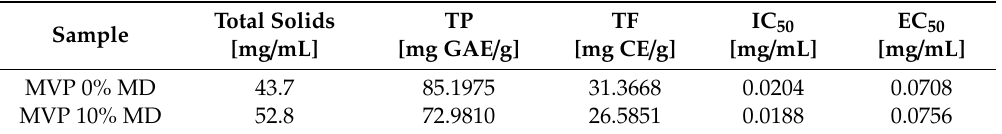
Table 6. Content (total phenols (TP) and total flavonoids (TF)) and antioxidant activity of MVPs determined by DPPH and reducing power assays.